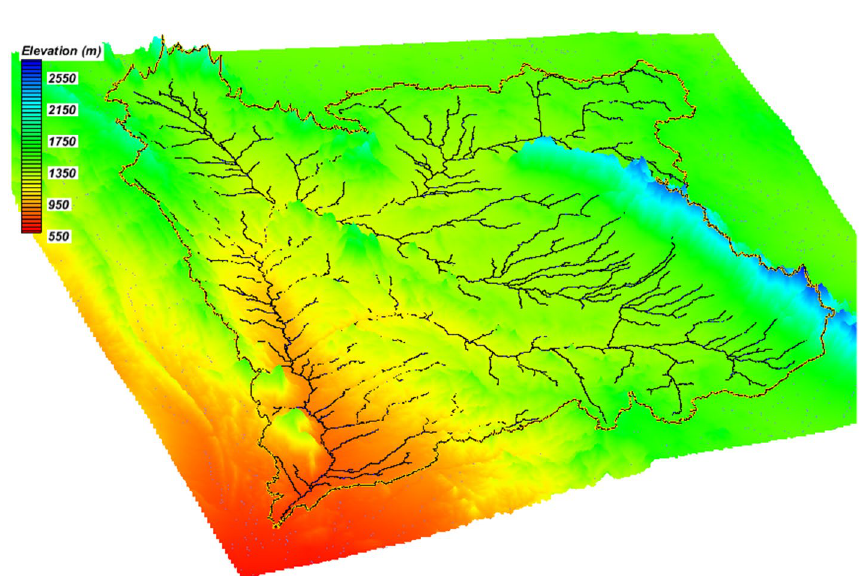
Fig. 6 3D view (5 V:1H) of physiographical conceptual model of Karvandar River